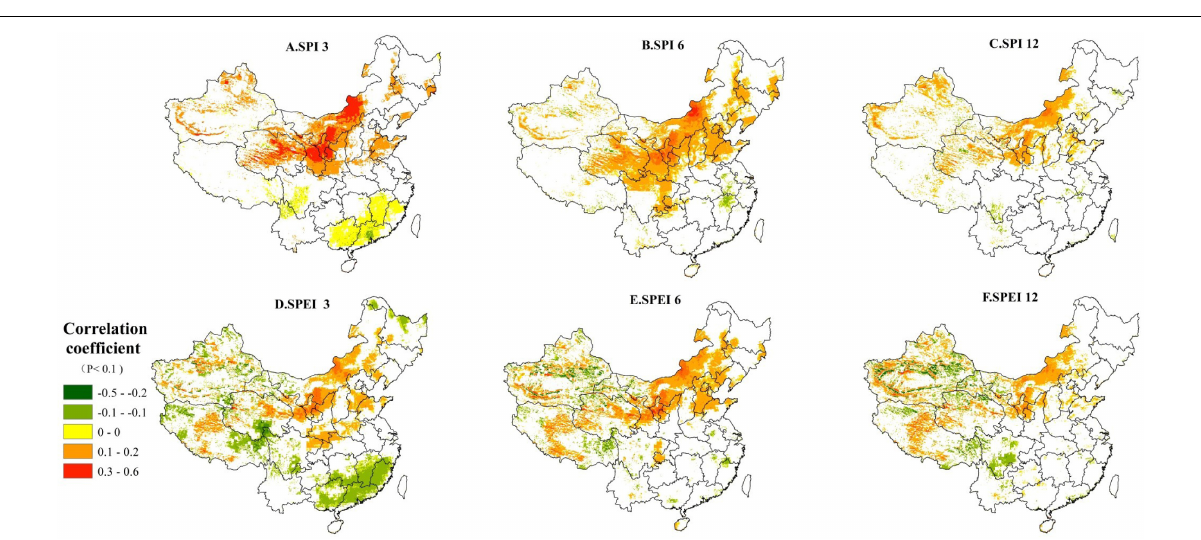
FIGURE 5 | The significant correlation coefficient (hereafter CC) between SPI/SPEI and monthly NPP ( P < 0.1 or 90% significance level). (A) CC between SPI3 and monthly NPP, (B) CC between SPI6 and monthly NPP, (C) CC between SPI12 and monthly NPP, (D) CC between SPEI3 and monthly NPP, (E) CC between SPEI6 and monthly NPP, and (F) CC between SPEI12 and monthly